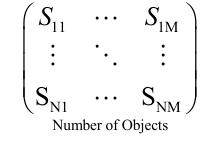
Fig. 5. HM representation for 1D